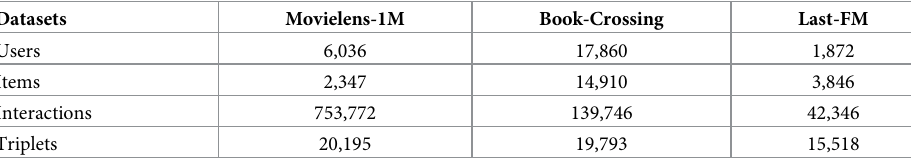
Table 1. The details of the three real-world